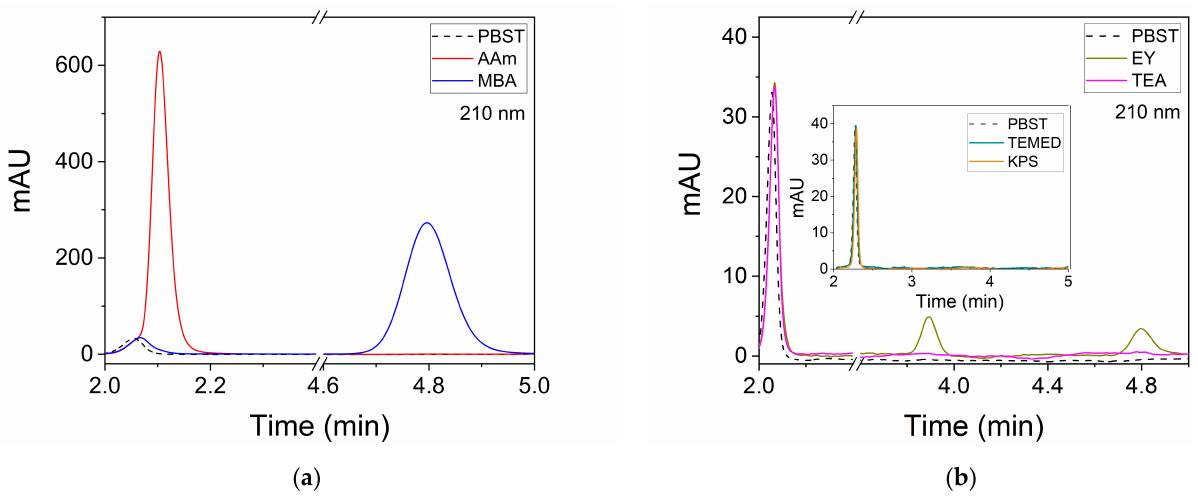
Figure 2. Chromatograms (mAU = mili OD at 210 nm) of standard solutions of the compounds used for the storage of holograms in the hydrogel matrices. ( a ) AAm and MBA; ( b ) EY, TEA, TEMED and KPS. The concentration of each compound is 50 ppm. The solvent used is PBST. Detection is carried out at 210 nm with a diode array detector.